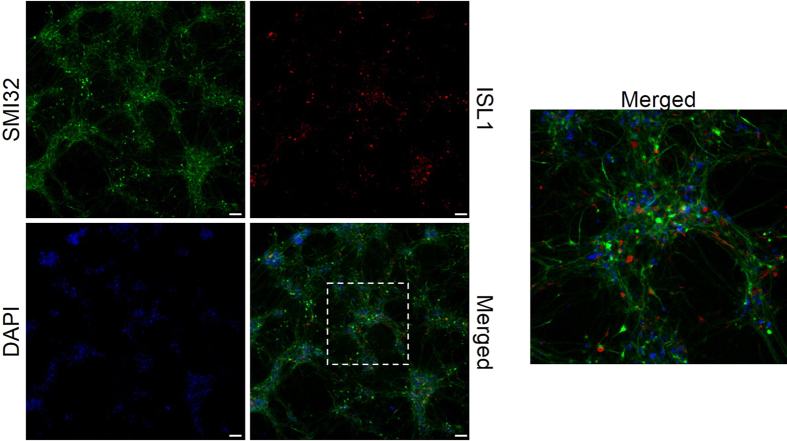
Fibroblast-derived iPSCs differentiate into SMI32- and ISL1-positive motor neurons.Differentiated cells were labeled to evaluate the immunoreactivity of SMI32 (green) and ISL1 (red) proteins, two markers of mature motor neurons. Nuclei were stained with DAPI. Motor neurons were imaged with 10x magnification. The image on the right represents a higher magnification of selected neurons. Scale bar = 75 μm.